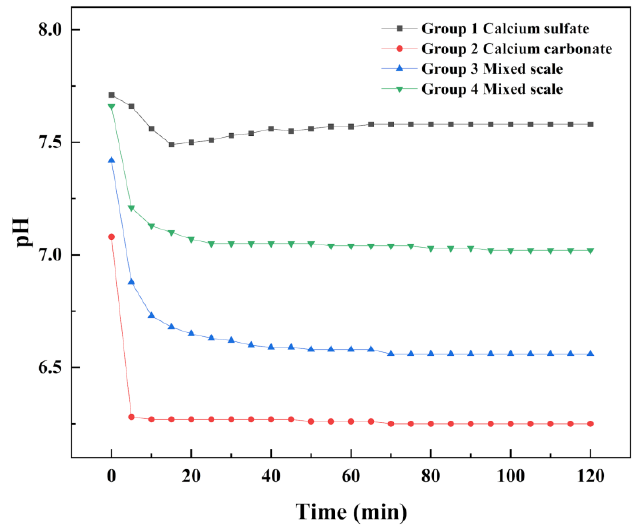
Figure 4. The change curve of pH with time, the solution was stirred at constant temperature by a con- stant temperature heating magnetic stirrer at 35 °C and 250 r/min for 120 min.